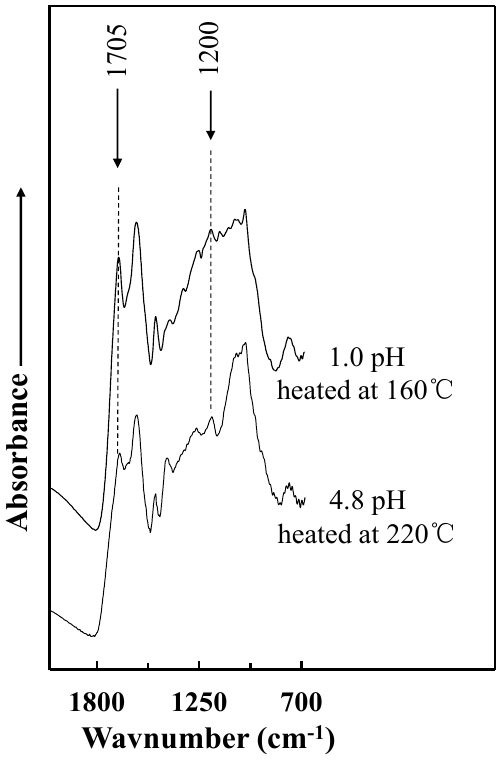
Figure 5. FT-IR spectra of insoluble matter obtained from cured adhesives.